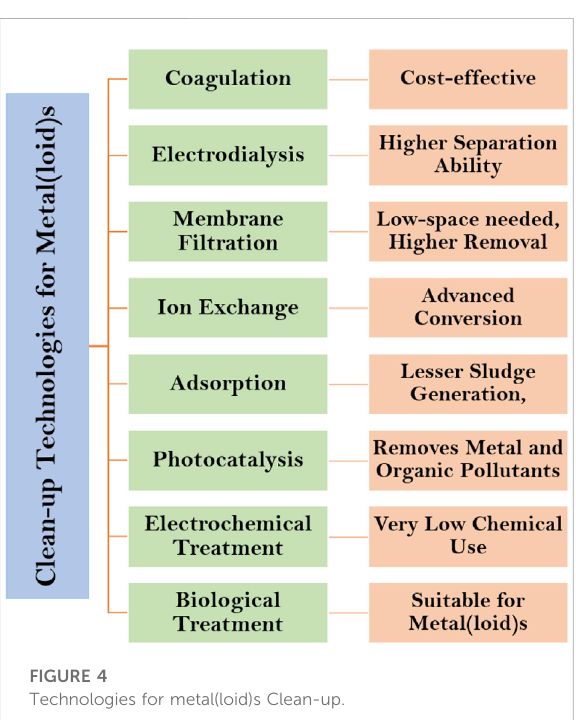
FIGURE 4 Technologies for metal(loid)s